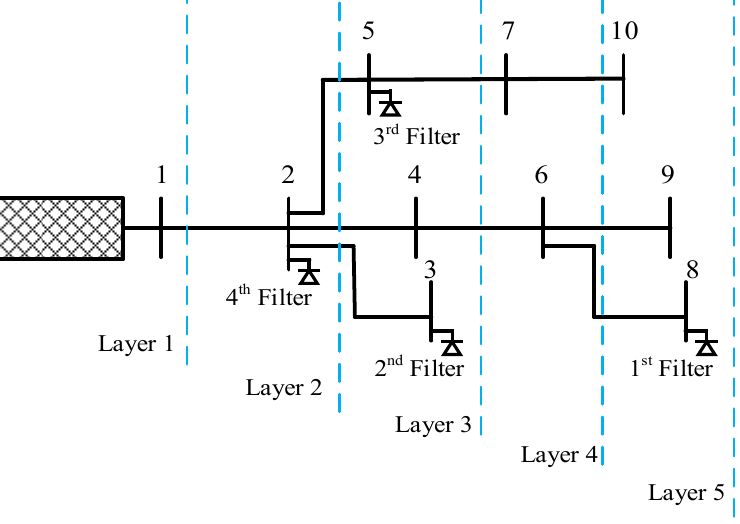
Figure 3. A typical example to form priority list of SACAPFs.